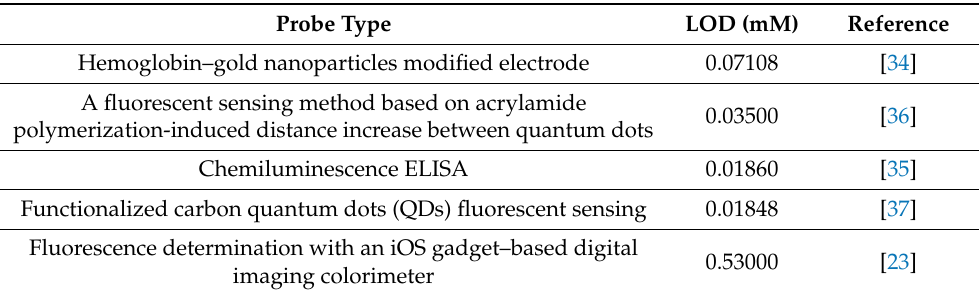
Table 1. The reports on the LOD of acrylamide.